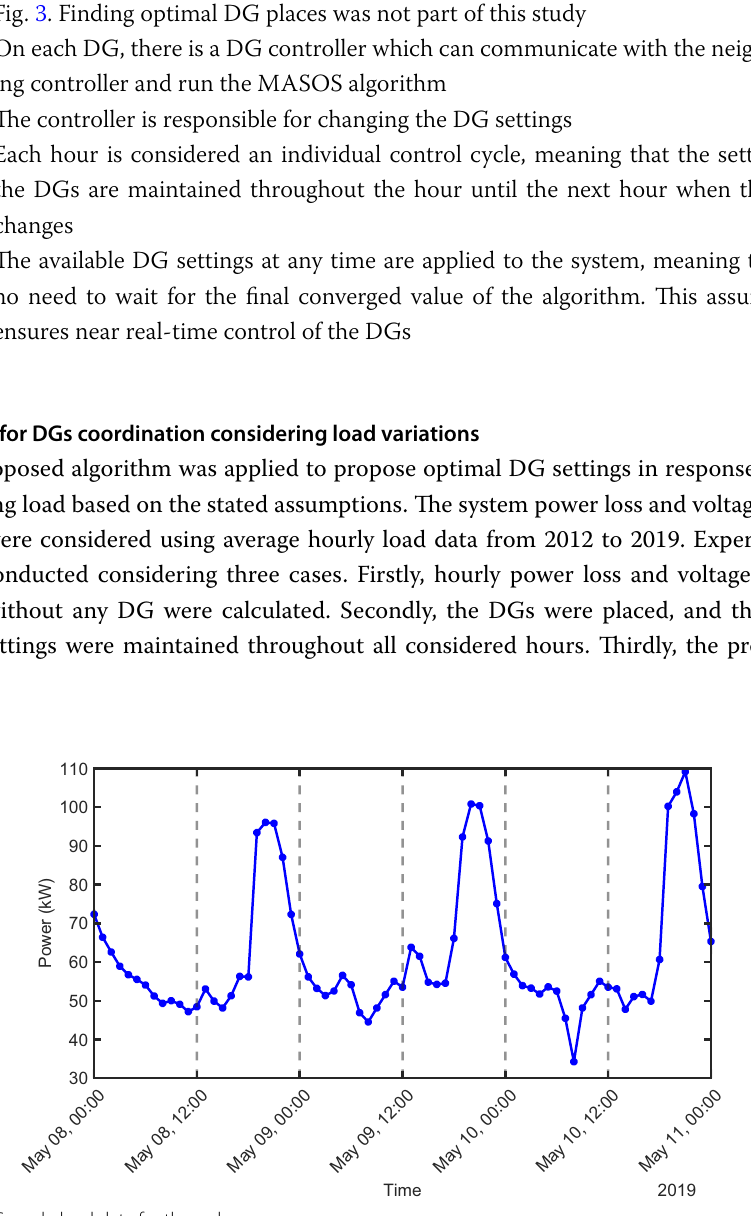
Fig. 4 Sample load data for three